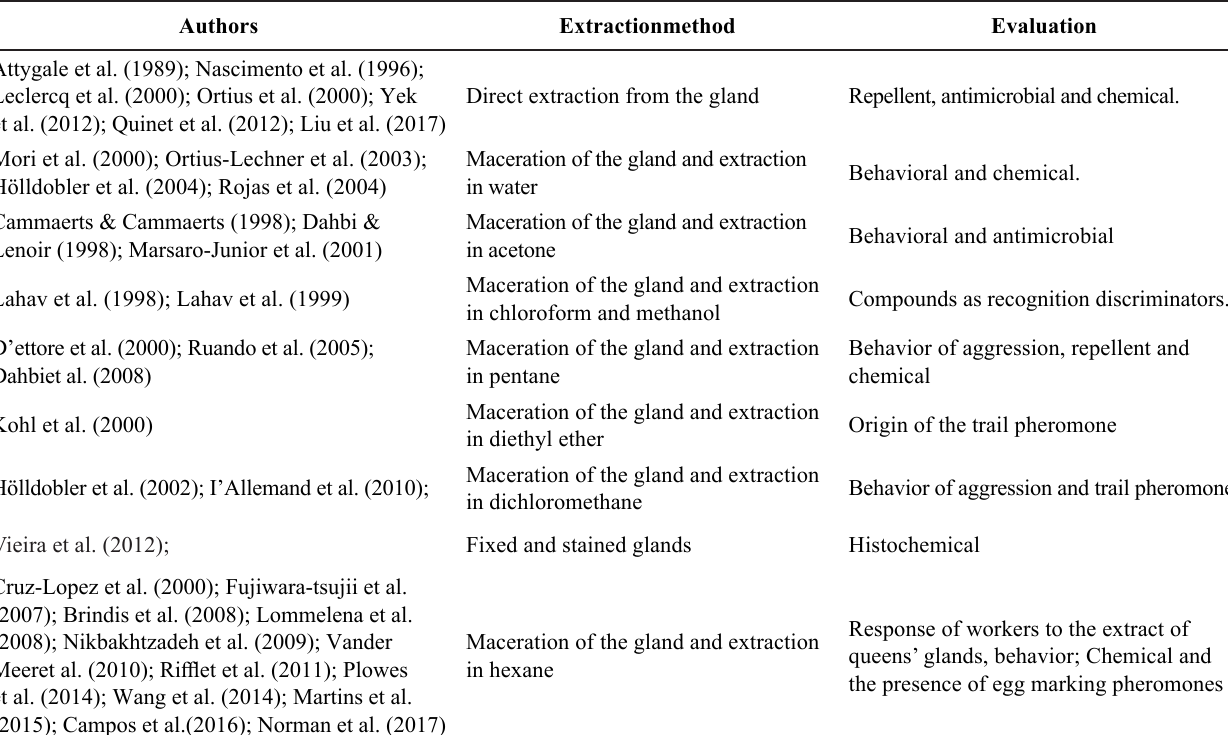
Table 2 . Articles with different methods of extraction and evaluations to test the origin and functions of substances extracted from